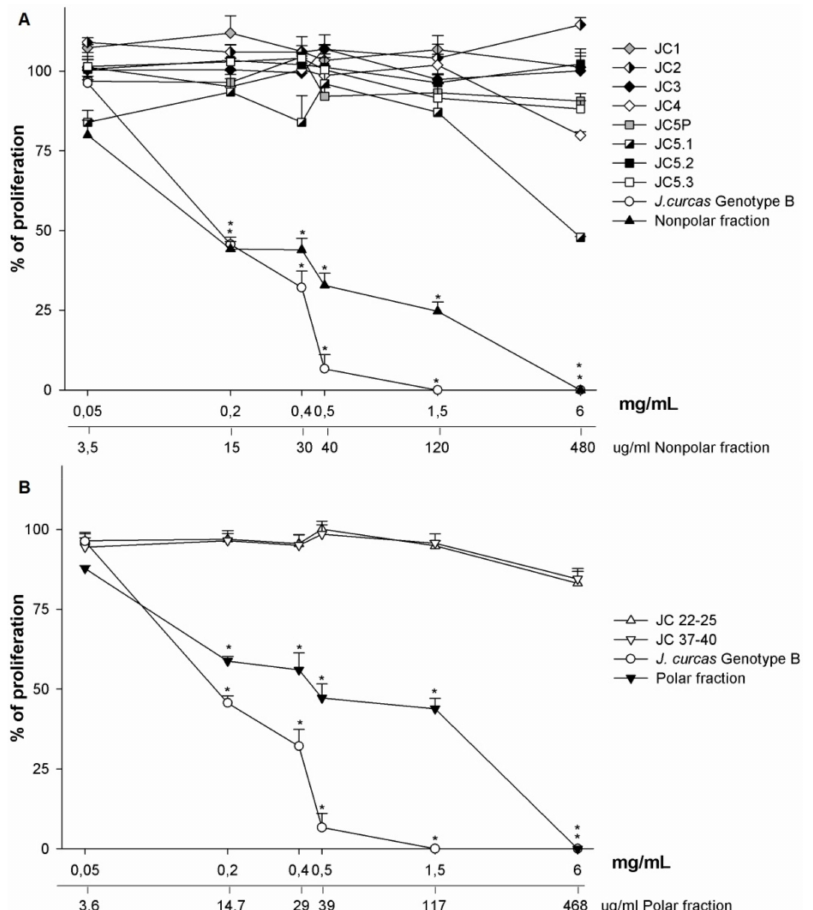
Figure 9. E ff ect of J. curcas genotype B extract and some of its purified compounds from nonpolar ( A ) and polar ( B ) fractions, measured by MTT test after 48 h treatment. For each fraction and for each substance, concentrations tested were chosen according to the concentrations used for the total extract and in relation to their percentage content. Data represent the mean ( ± SE) of one experiment done in triplicate. For clarity, only positive error bars are shown. * p < 0.05 vs. control (Dunnett’s